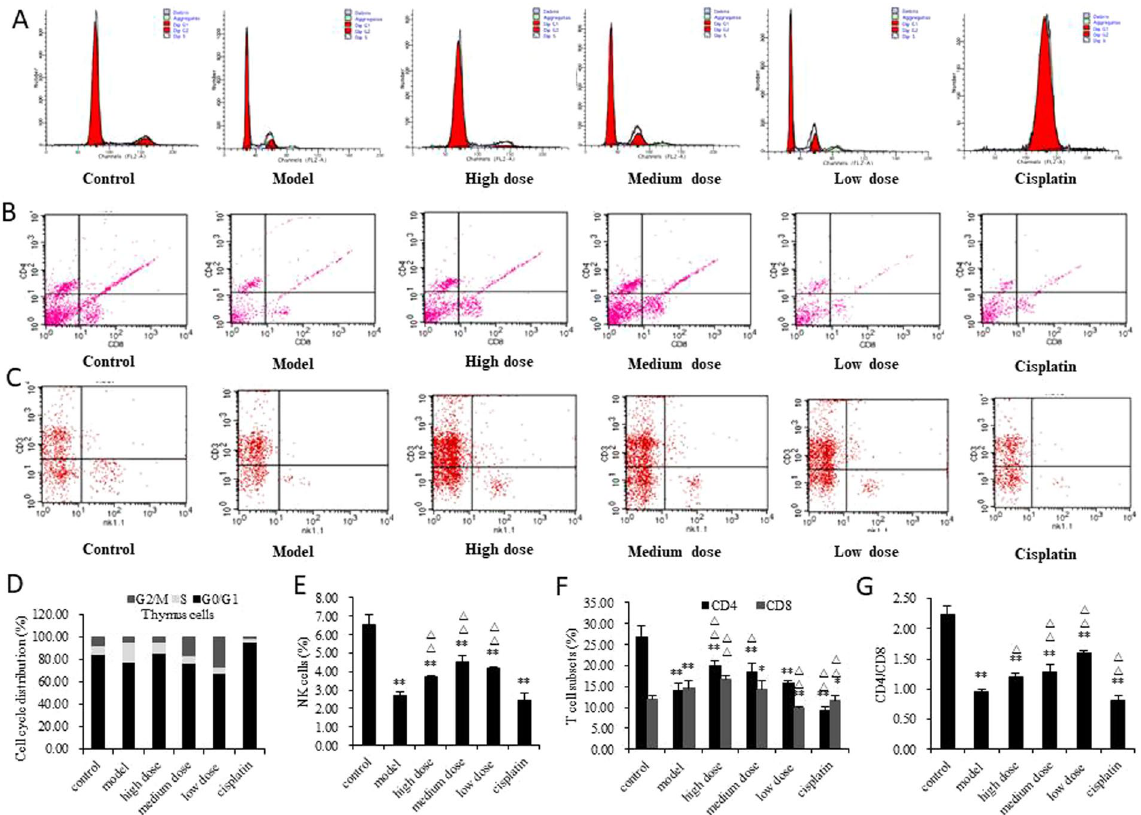
Figure 3. Effect of GLE on immunostimulatory activity of tumor-bearing mice was determined. ( A , D ) GLE improved the suppression of thymus cells in tumor-bearing mice. Cell cycle distribution was analyzed by FACS, in order to detect the effect of GLE on the cell cycle progression of thymus. ( B , F , G ) Effects of GLE on T cell subsets in peripheral blood in tumor-bearing mice were detected. The lymphocyte subsets were detected by flow cytometry. The lymphocyte subset analysis included CD3 + (T lymphocyte), CD4 + (T-helper cells) and CD8 + (T-suppressor cells). Representative results of three independent experiments are shown. ( C , E ) Effects of GLE on NK cell activity in tumor-bearing mice. The percentage of NK cells were quantified by FACS. Error bars, SD; * P < 0.05; ** P < 0.01, versus control values; Δ P < 0.05; ΔΔ P < 0.01, versus model values.